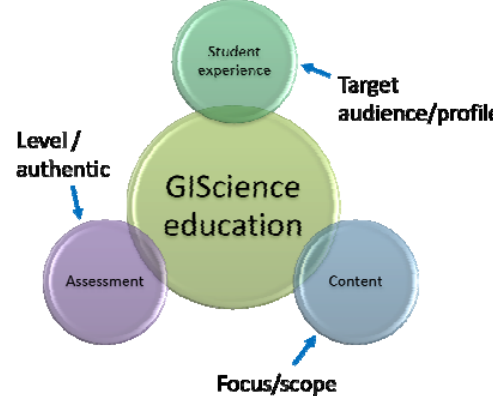
Figure 2: Mandatory components of a GIScience education